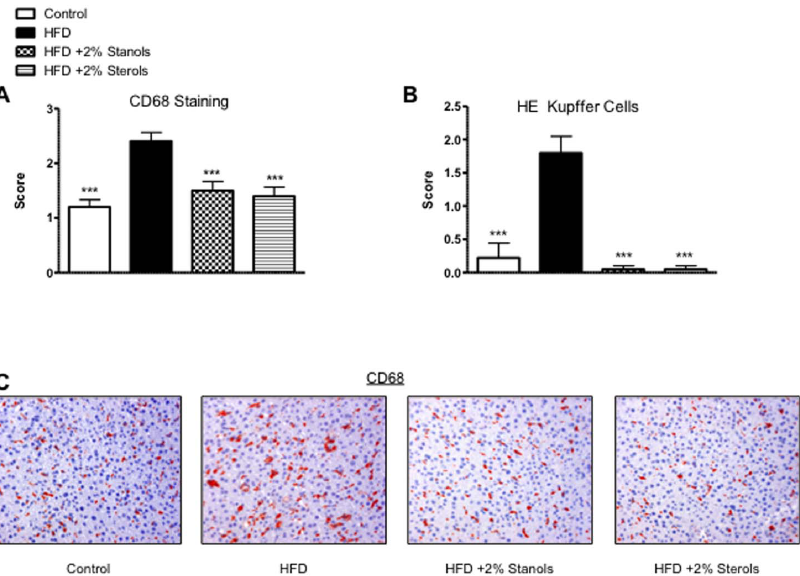
Figure 3. Foamy Kupffer Cells. (A) Scoring for the size and foamy appearance of Kupffer cells using CD68 staining. (B) Scoring for the size and foamy appearance of Kupffer cells using HE staining. A score ranging from 0–3 was given by an experienced pathologist. (C) Representative pictures of the foamy Kupffer cell appearance with CD68 staining (200x magnification). *P , 0.05, **P , 0.01, and ***P , 0.001, respectively.